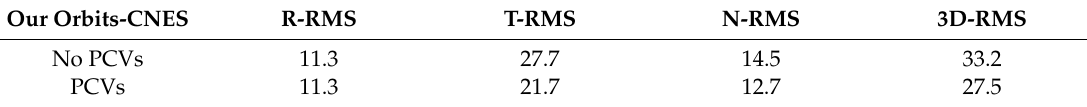
Table 3. Mean RMS of differences between Jason-3 orbits and CNES orbits [unit: mm]. Our Orbits-CNES